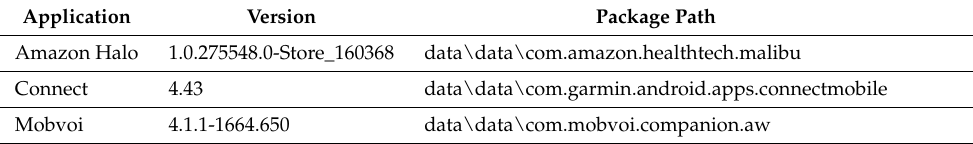
Table 5. Android Package Paths for Forensically Relevant Data From The Fitness Applications.